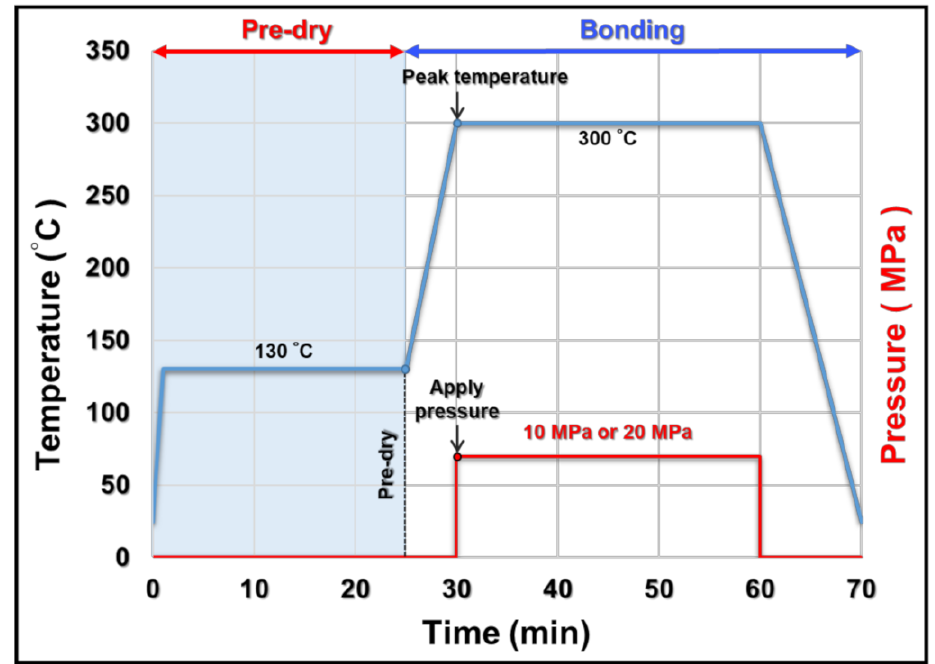
Figure 3. Temperature and pressure profiles for the sintering process.